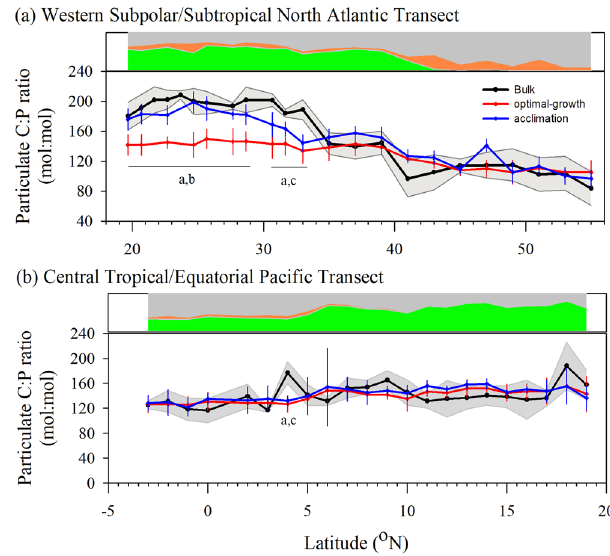
Fig. 5 Measured and modeled euphotic zone particulate carbon-to- phosphorus stoichiometric ratios. Euphotic zone averaged particulate organic carbon-to-phosphorus (C:P) stoichiometric ratios along ( a ) a transect in the western North Atlantic Ocean and ( b ) a transect in the central Tropical/Equatorial Paci fi c. The black line is the euphotic zone (0 – 100 m) average ratio of bulk POM measurements, and the gray shading is the 95% con fi dence interval around the euphotic zone average ratio. The red line is the optimal-growth phytoplankton model estimate of particulate C:P ratio, and the blue line is the acclimation model estimate of particulate C:P ratio. For both models, the error bars at each station represent the 95% con fi dence interval range. The western North Atlantic transect was comprised of two cruises, both in August/September, with the northern half (31°N – 55°N) conducted in 2013 (Cruise AE1319), and the southern half (19°N – 33°N) conducted 2014 (BVal 47). The central Tropical/Equatorial Paci fi c transect was a single cruise (NH1418). Signi fi cant differences between models and observations at each station are represented in the following manner: ‘ a ’– observations are signi fi cantly different from the predictions of the optimal-growth model; ‘ b ’– predictions from the optimal- growth model are signi fi cantly different from the predictions of the acclimation model; and ‘ c ’– observations are signi fi cantly different from the predictions of the acclimation model. Above each panel is a stacked area plot of the relative contribution of cyanobacteria Prochlorococcus (green fi ll), Synechococcus (orange fi ll), and eukaryotes (gray fi ll) to total measured autotrophic C along the